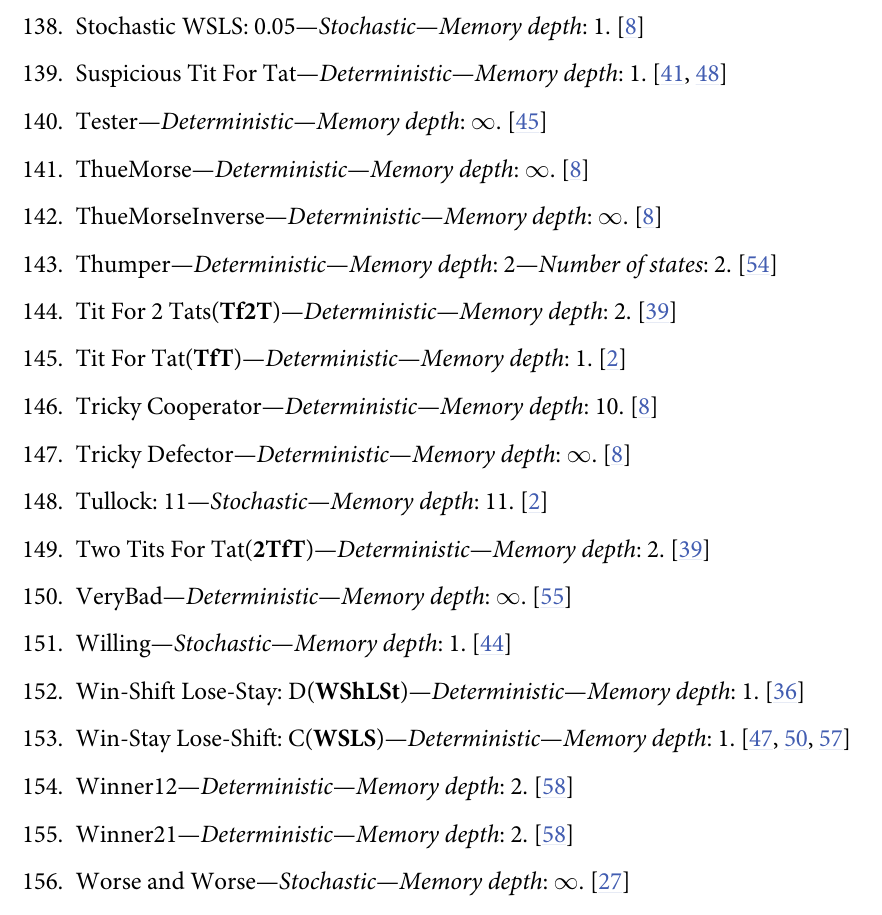
for N = 3. 1 for N = 1